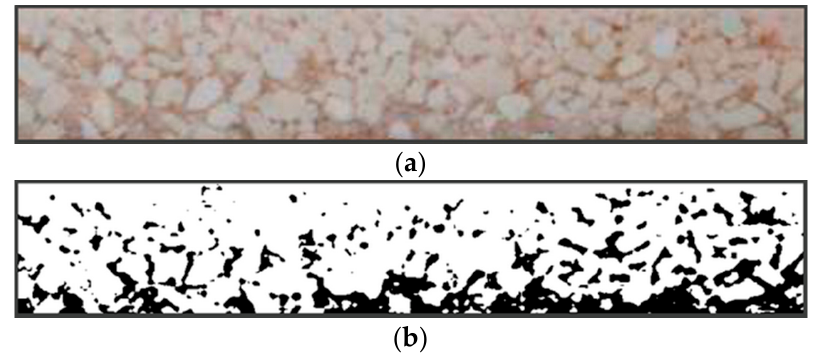
Figure 10. A cross-section of the composite sample narrowed on the bottom (piezoelectric) layer with densely packed PZT grains: ( a ) original image; ( b ) binary image.